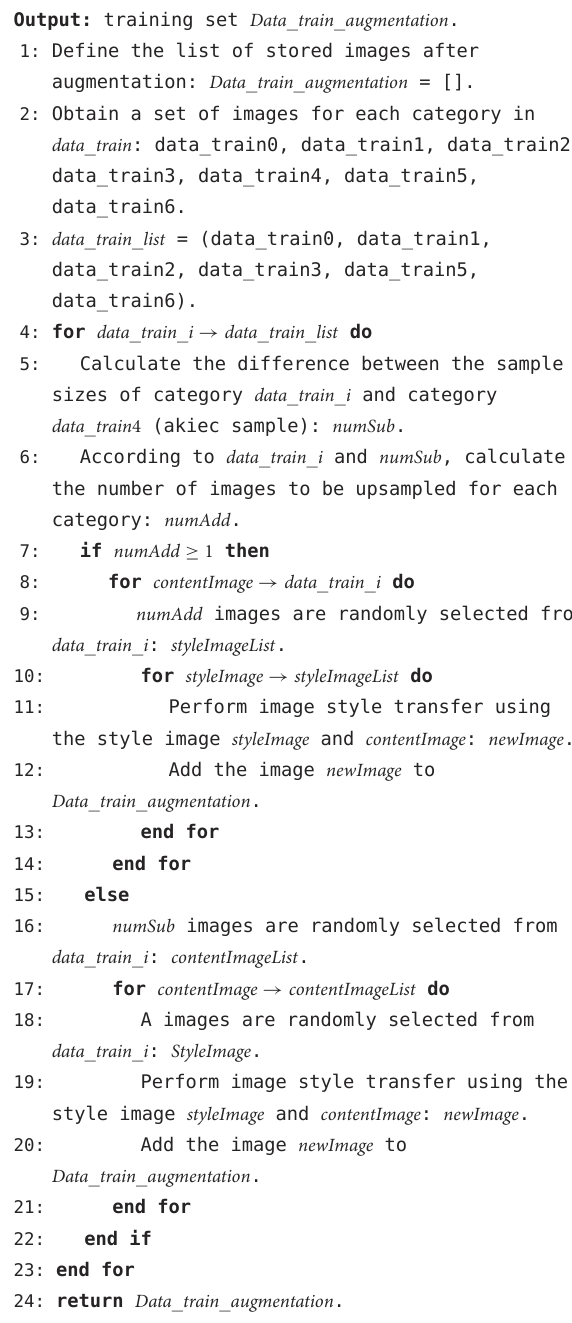
Algorithm 2. Image augmentation—image style transfer.